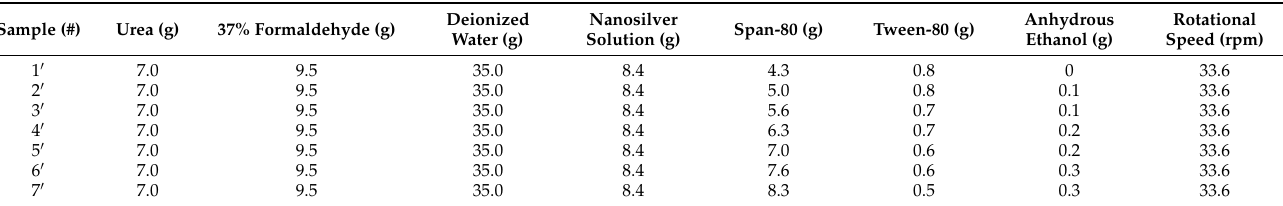
Table 4. The schedule for different HBL